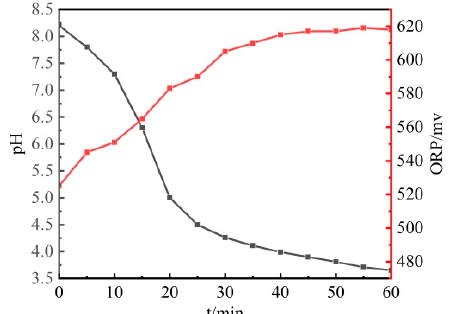
Figure 7. Time courses of pH and ORP value during the reduction by NaClO 2 . Reaction conditions: NaClO 2 concentration 0.008 mol/L; initial pH 8.7; temperature 30 °C; NO inlet concentration 500 ppm; N 2 balance, with a total flow rate of 1.5 L/min.